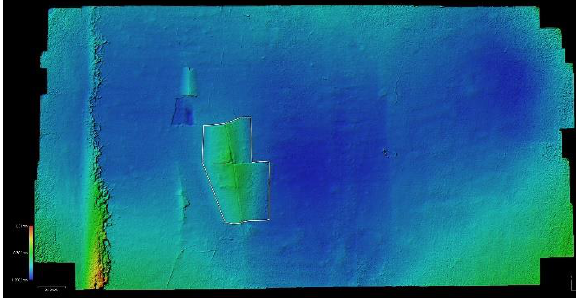
Figure 7. St. Constantine and Helen: DEM with marked lifted layer (Area 1)